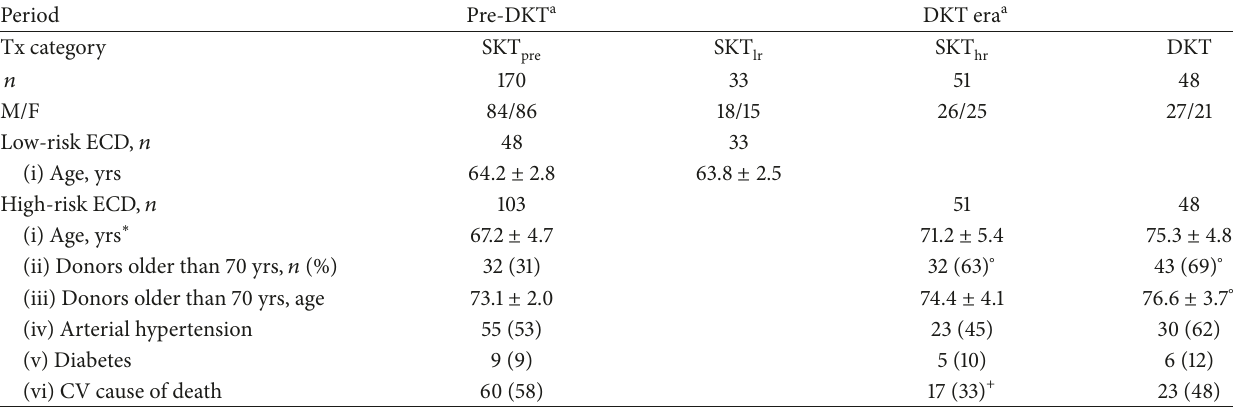
Table 2: Characteristics of donors older than 60 years according to period and transplant